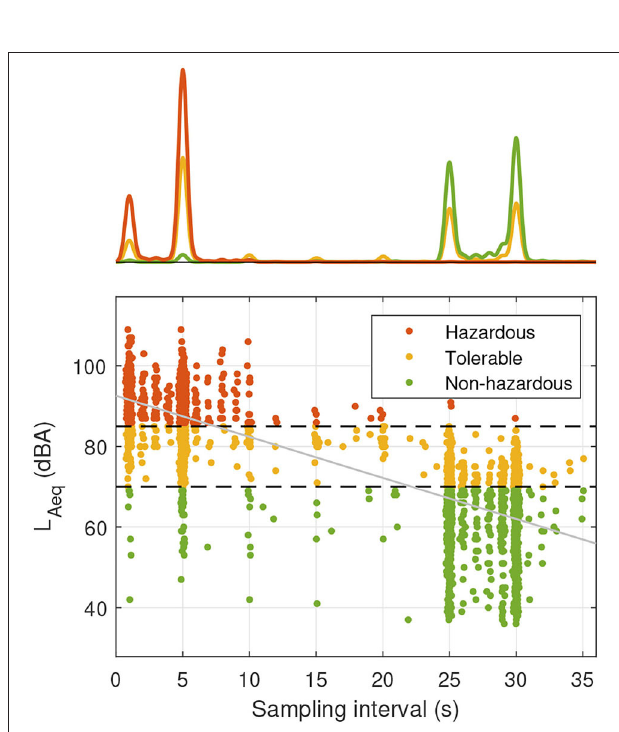
FIGURE 2 | Pie charts of the sample block distribution (mean L Aeq ) among the sound level categories.